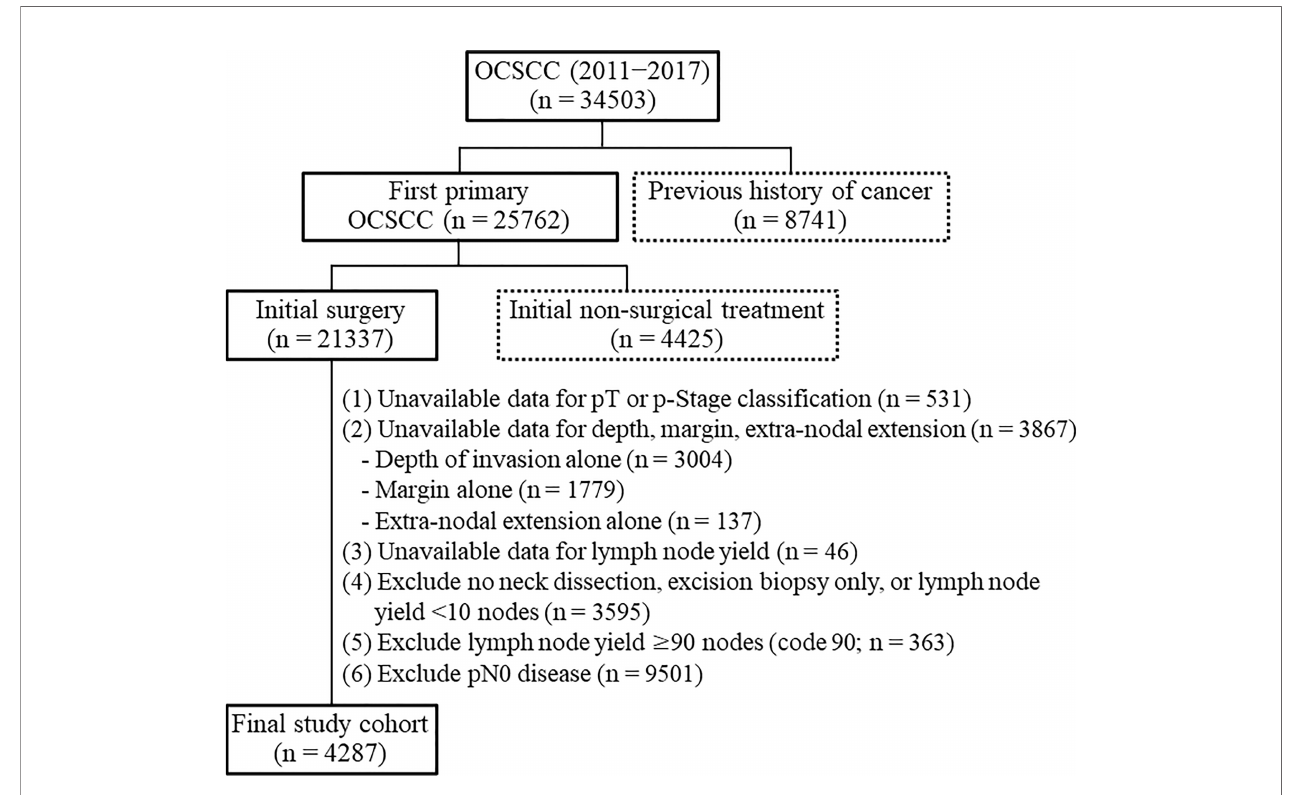
FIGURE 1 | Flow of patients through the